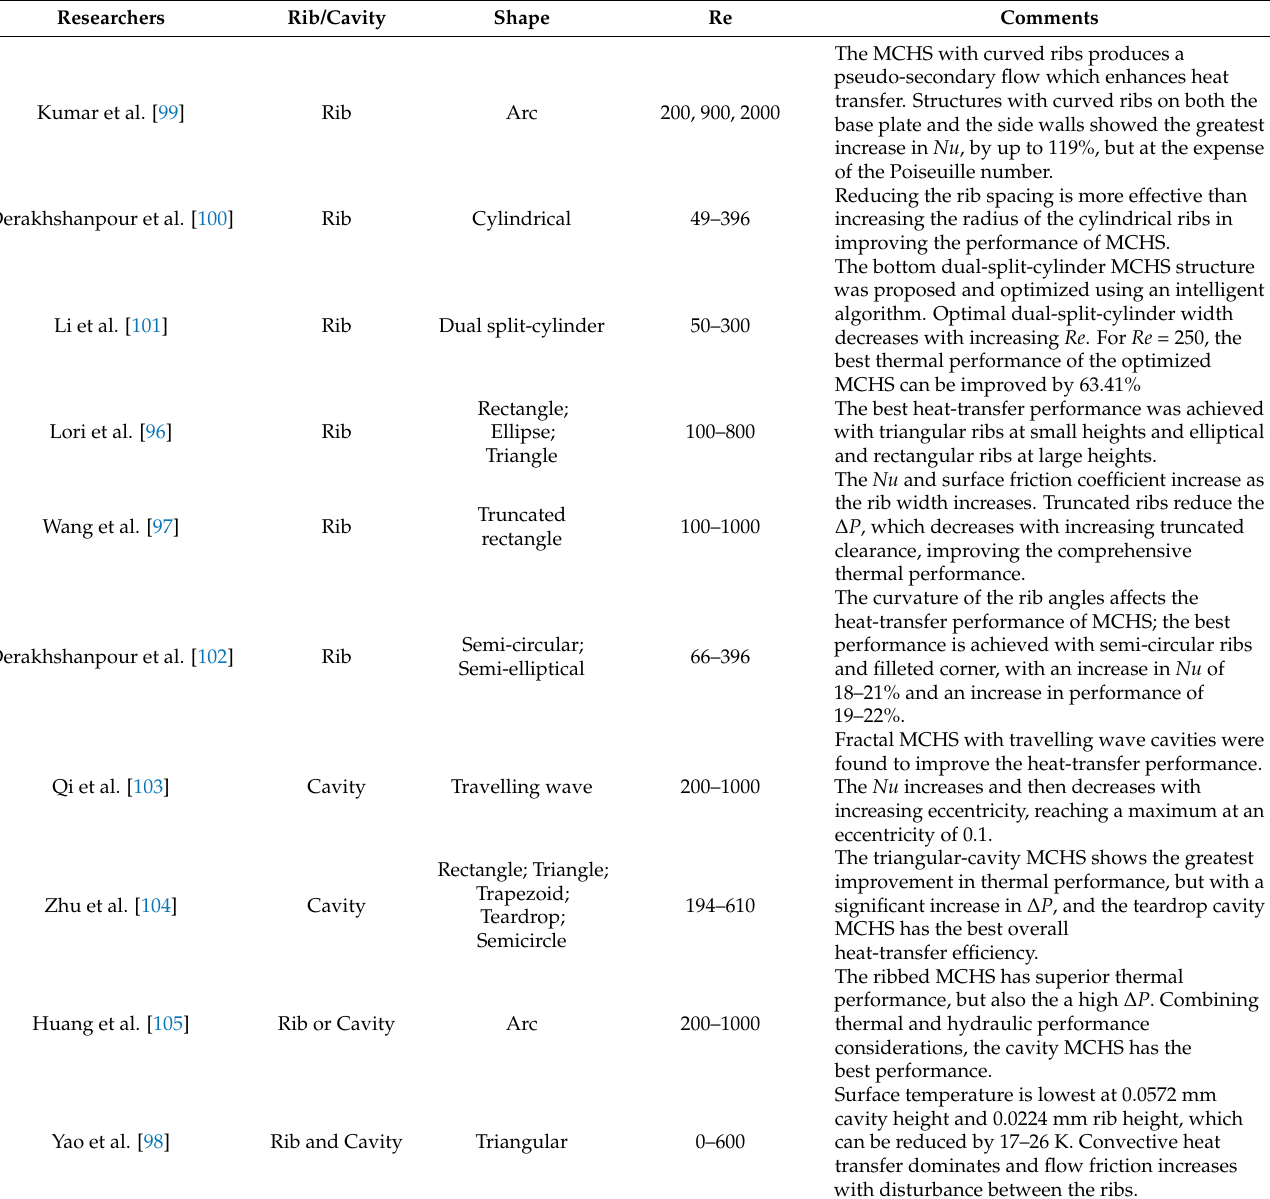
Table 4. Effect of ribs and cavities on the performance of